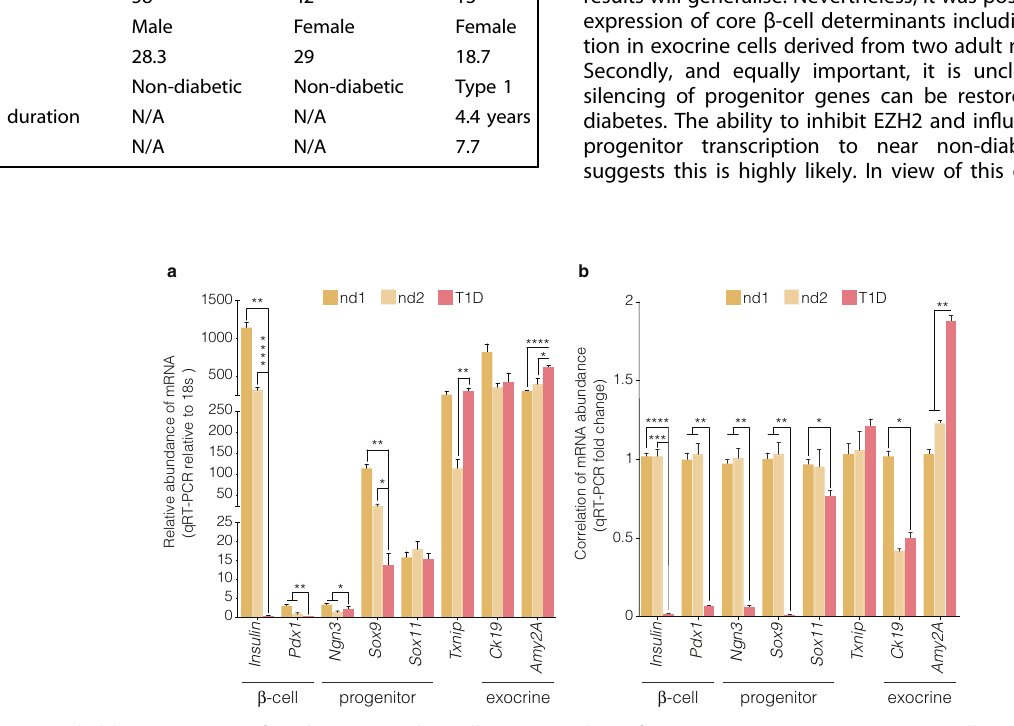
Fig. 2 Distinguishable expression of embryonic and β -cell mRNA indices from naïve pancreatic exocrine cells isolated from donors. Abundance of Ins , Pdx1 , Ngn3 , Sox9 and Txnip mRNA. a Expression analyses in naïve exocrine cells showing the comparative abundance of mRNA relative to 18s assessed by qRT-PCR. Relative expression of mRNA isolated from non-diabetic (nd) and type 1 diabetic (T1D) donors. b Correlation of mRNA expression of Ins , Pdx1 , Ngn3 , Sox9 and Txnip displayed as a function of fold change. Expression analyses of mRNA isolated from non-diabetic (nd) and type 1 diabetic (T1D) donors. Signi fi cance is calculated by comparing nd1 v T1D and nd2 v T1D. Student t test, * P < 0.05, ** P < 0.01, *** P < 0.001, **** P < 0.0001. Error bars represent SEM, n = 2